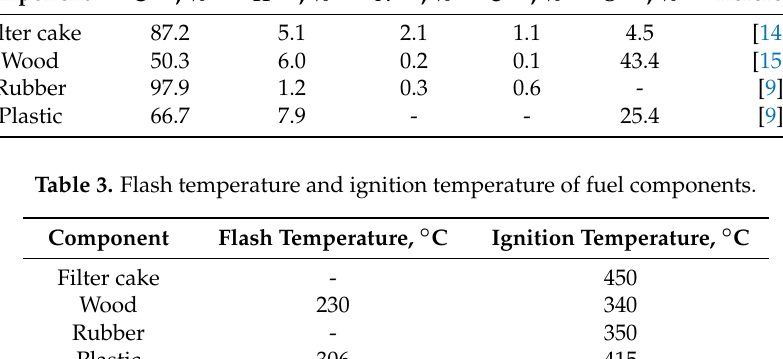
Table 2. Properties of fuel components [9,14,15]. Ultimate analysis.